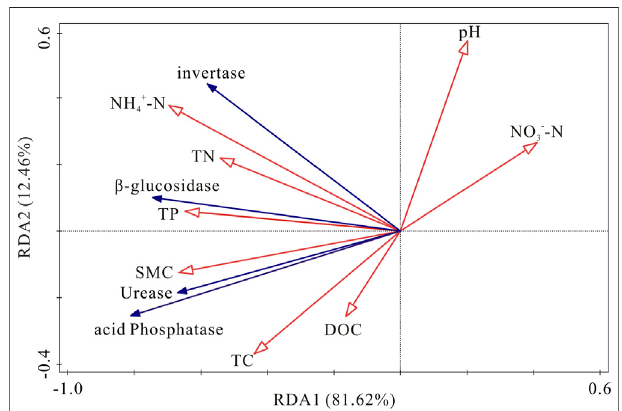
FIGURE 6 | Redundancy analysis of soil enzymes activities and soil physicochemical properties. SMC: soil moisture content; TC: total carbon;